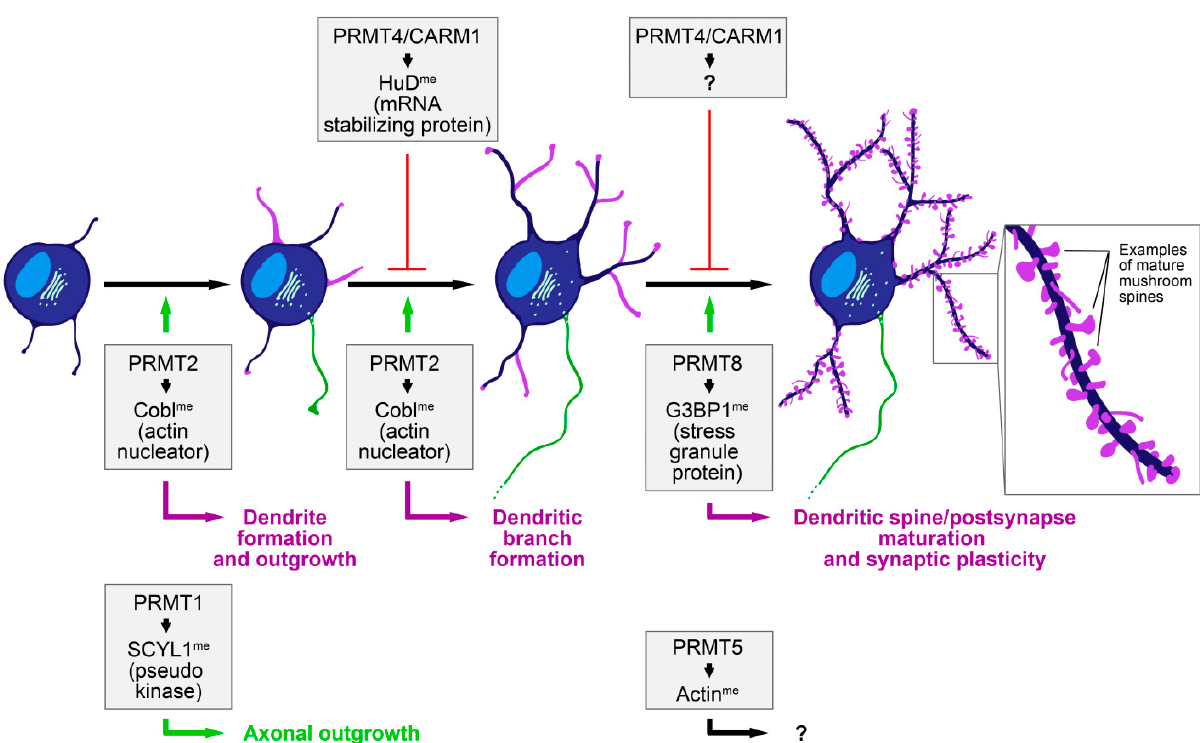
Figure 3. Neuronal development and the roles of individual PRMTs. Schematically depicted is a neuron undergoing neurite (left), dendrite (dark purple and magenta) and axon (green) formation as well as the outgrowth of these distinct compartments (second from left), dendritic branch formation giving rise to an extended and complex dendritic arbor (second from right) and dendritic spine formation and maturation (right). Morphological additions to dendrites in comparison to the previous stage are in magenta. Extensions of previously present structures are indicated by growth cones in magenta. Further structures present in the cell body are the nucleus (light blue) and the Golgi apparatus and additional secretory vesicles (light green). The information on PRMTs include arginine methylated ( me ) cellular targets (if identified) that are thought or have experimentally been demonstrated to bring about the respective neurodevelopmental function indicated. Whether a PRMT5-mediated methylation of actin plays a role in the nervous system is unknown and therefore not assigned to any neurodevelopmental stage or function.